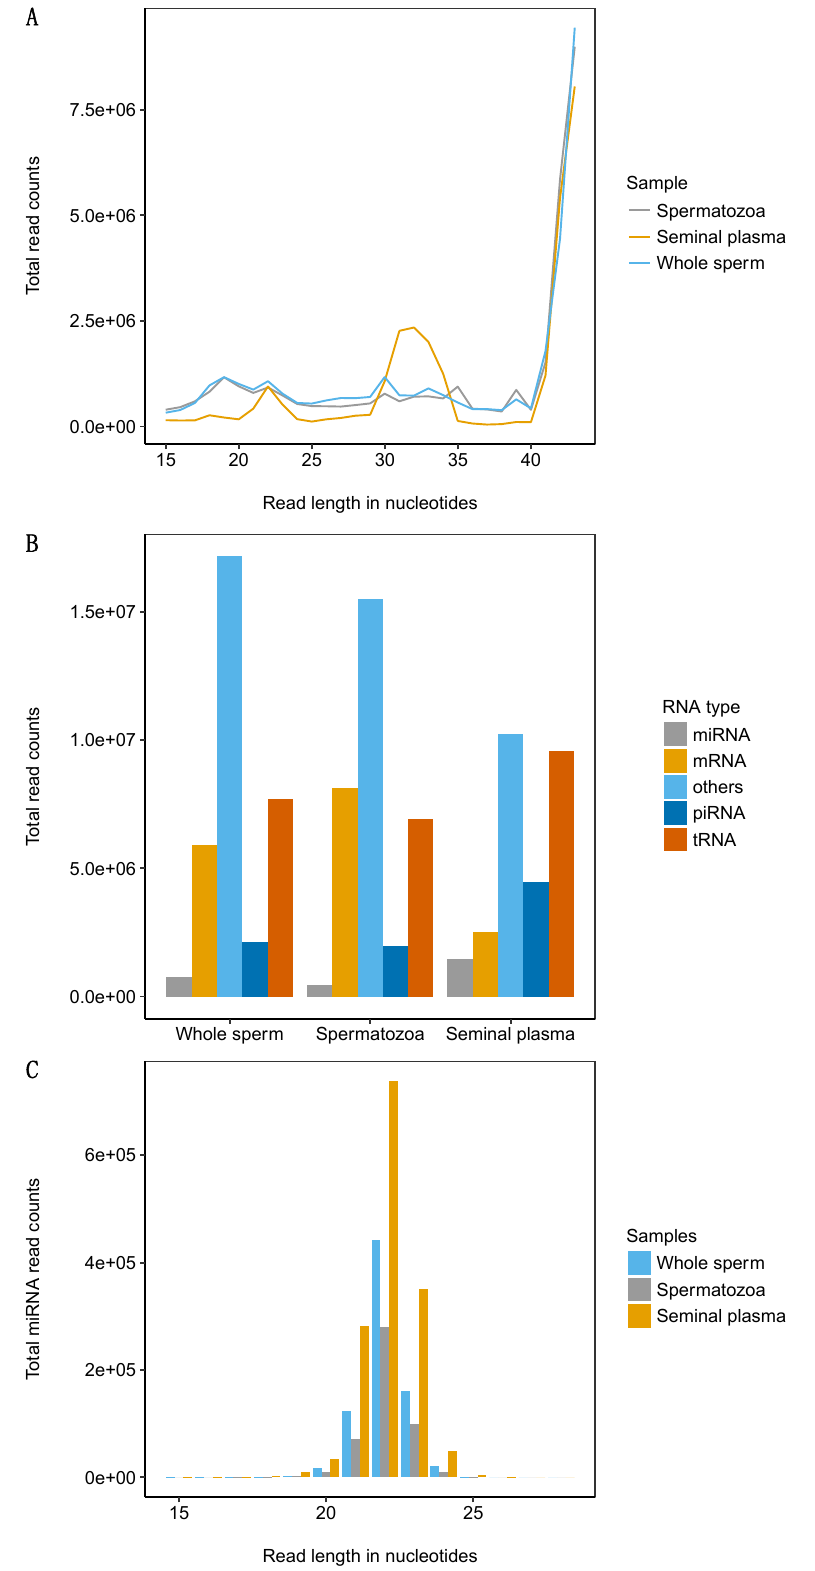
Figure 1. Major composition of small RNAs in Atlantic salmon sperm. ( A ) Sequence length distribution for each small RNA library of whole sperm, spermatozoa and seminal plasma. ( B ) Annotated RNA types. ( C ) micro RNA (miRNA) size distribution in the whole sperm, spermatozoa, and seminal plasma.